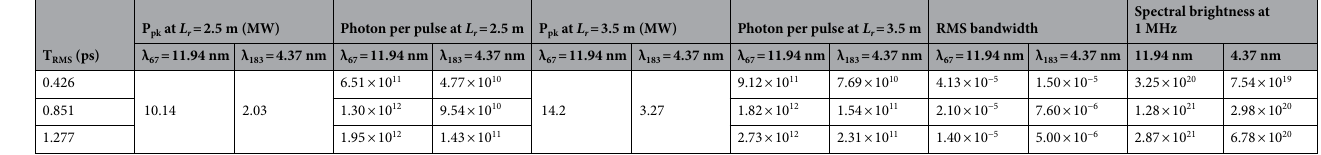
Table 3. CR for the lower and upper wavelengths of carbon k-edge 4.37 nm and 11.94 nm, including the peak power, the number of photon pulse, and the RMS spectral bandwidth in three different pulse durations in RMS, 0.43 ps, 0.85 ps, and 1.23 ps are listed. For each case, those output properties are calculated at two different radiator lengths, 2.5 m, and 3.5